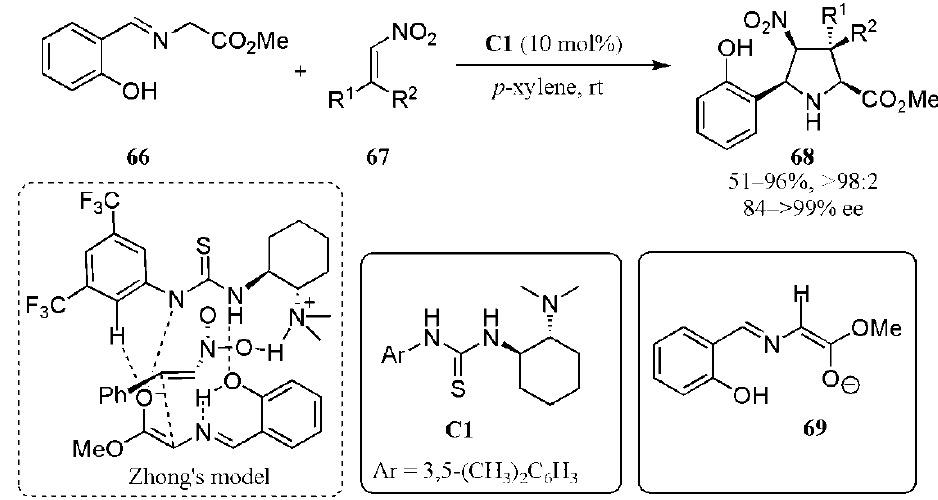
Figure 38. Synthesis of pyrrolidines by 1,3-dipolar cycloaddition of 66 with nitroalkenes 67 under bifunctional catalysis [77].